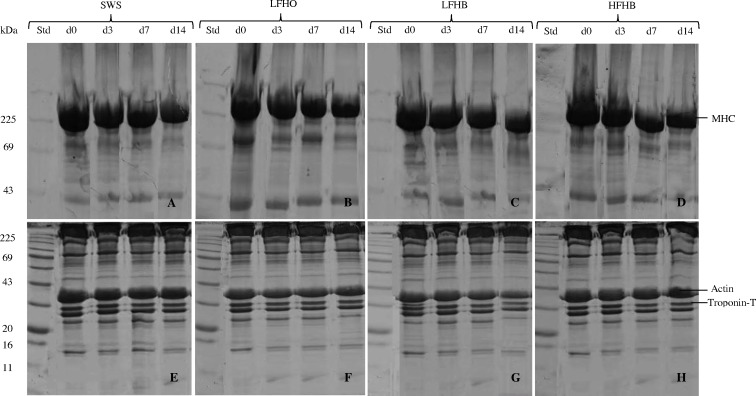
Representative SDS-PAGE showing myosin heavy chain (MHC), actin and troponin-T bands of longissimus lumborum muscle during postmortem aging periods in goats subjected to slaughter without stunning and slaughter following different methods of electrical stunning.Equal amount of protein (20 μg) of each sample was loaded and electrophoresed on a separate 5% (A, B, C, D) and 12% (E, F, G, H) SDS-PAGE under 120 V of constant voltage for about 90 min. The gels were then stained with coomassie blue staining for 60 min and destained with destaining solution for 45 min. The bands of MHC, actin and troponin-T were visualized using GS-800 Calibrated Imaging Densitometer. SWS: slaughter without stunning, LFHO: low frequency head-only, electrical stunning, LFHB: low frequency head-to-back electrical stunning, HFHB: high frequency head-to-back electrical stunning.